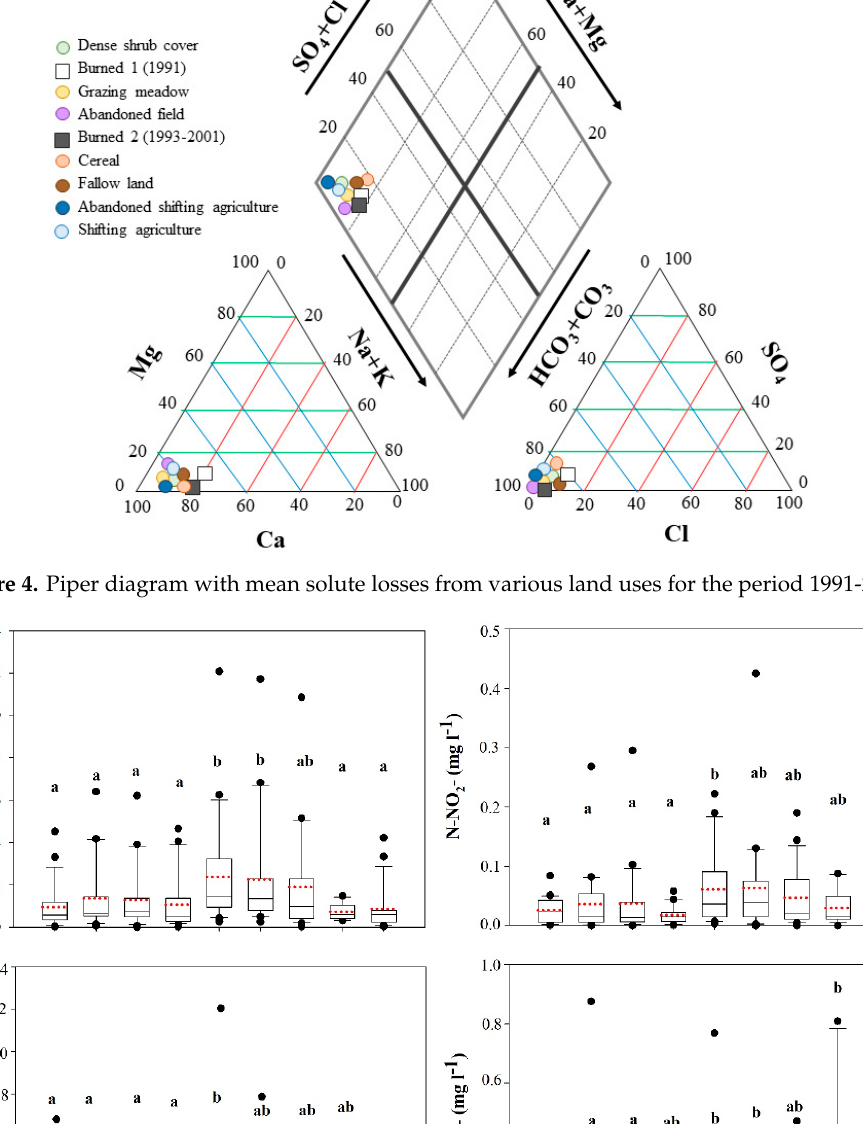
Figure 4. Piper diagram with mean solute losses from various land uses for the period 1991-2011.